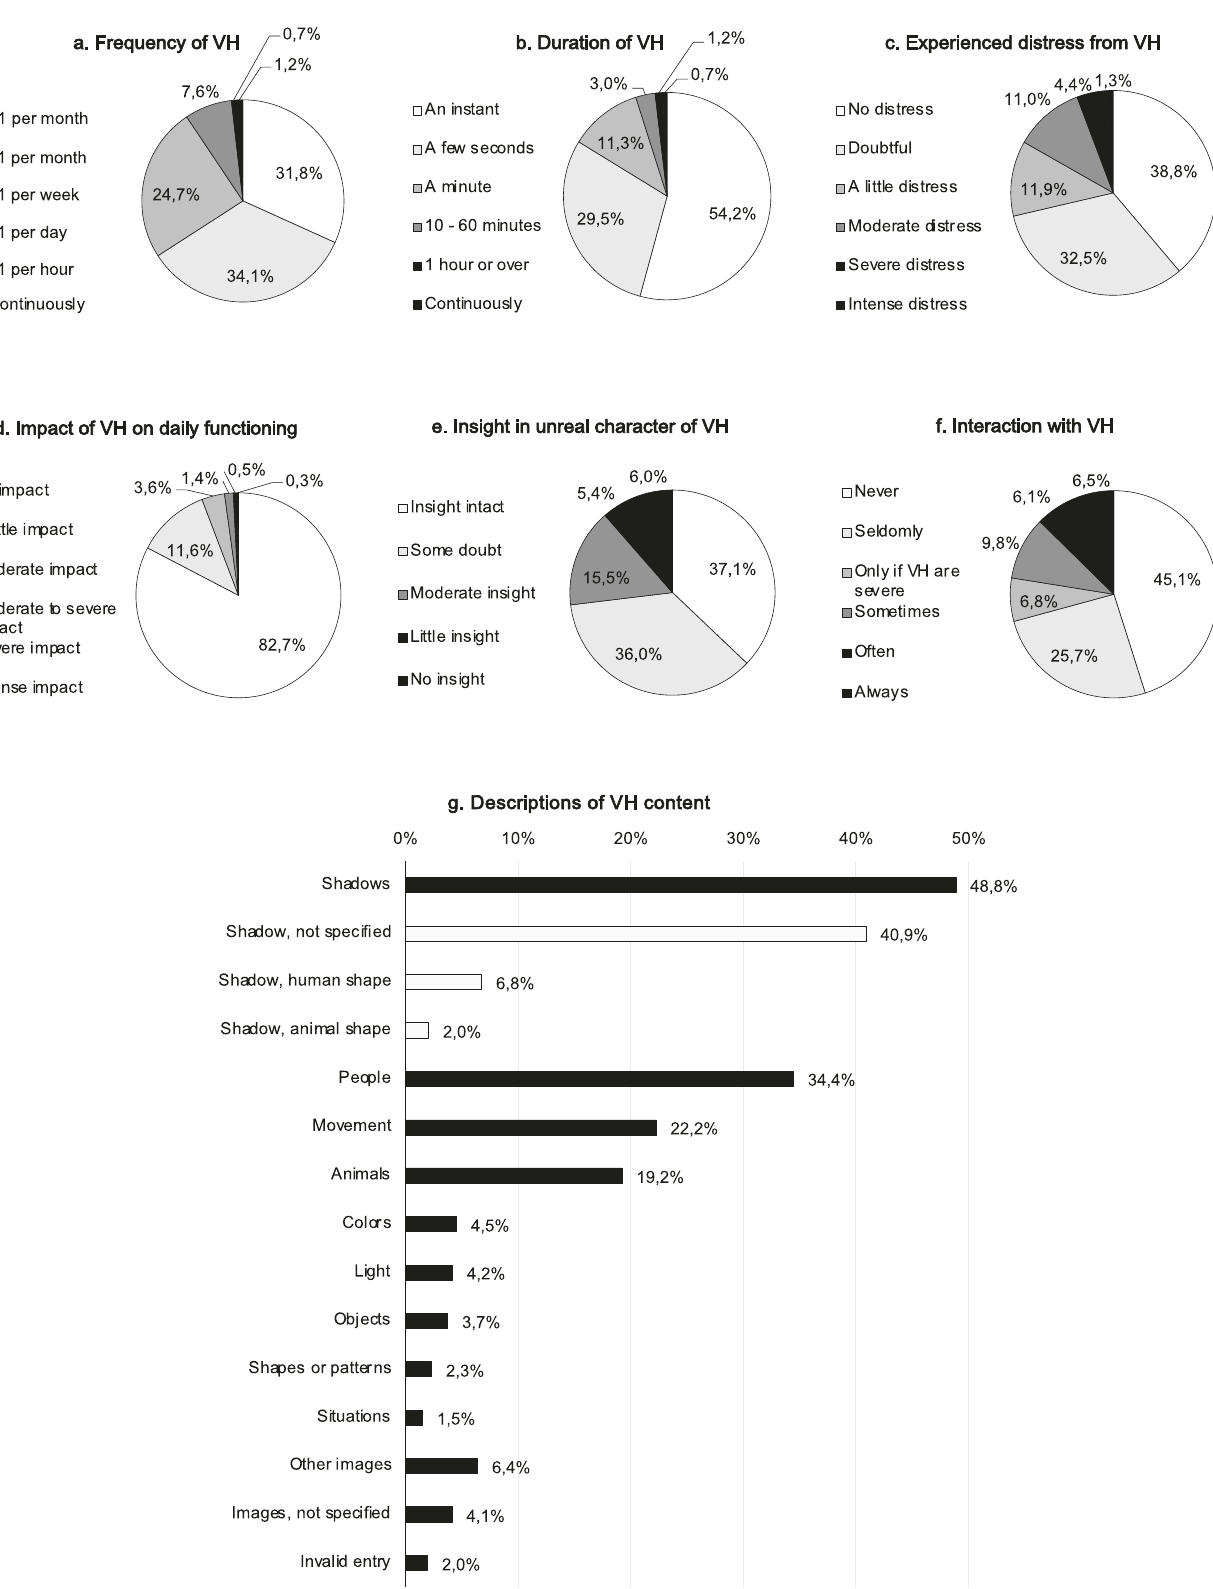
Fig. 3 Phenomenology of visual hallucinations in the past month. Total n (VH) = 2248. Additional phenomenological items are listed in Supplementary Fig. 4. Data are listed per QPE item, as obtained through multiple choice items withone answer possibility ( a – f ) and an open question, asking participants to describe the experienced content of VH ( g ; total percentage exceeds 100%). Invalid entries VH ( g ): incomplete or incomprehensible information ( n =